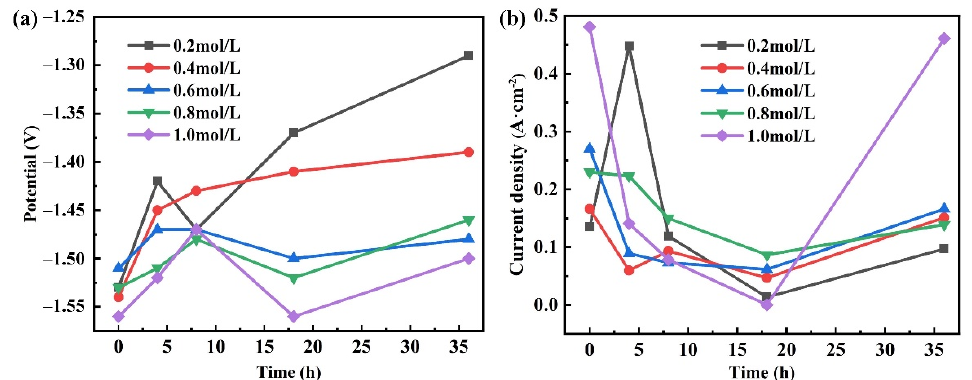
Figure 7. The change of the corrosion potential ( a ) and corrosion current density ( b ) in different solutions concentrations and duration of immersion.